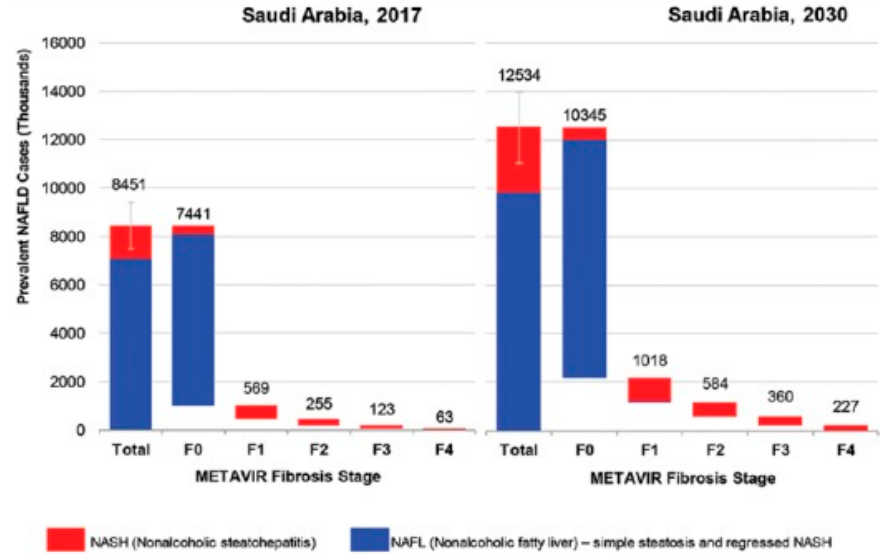
Figure 1. Distribution of NAFLD population by fibrosis stage—2017 and 2030, adapted from [4]. The progression of NAFLD involves four stages. Steatosis (simple fatty liver) is a harmless build-up of fat in the liver cells. A more severe form of NAFLD called NASH occurs when the liver becomes inflamed. A patient is diagnosed with fibrosis when persistent inflammation creates scar tissue around the liver and adjacent blood vessels, but the liver can still function normally. Cirrhosis, the most severe stage, develops after years of inflammation and causes the liver to shrink, scar, and lump; this damage is irreversible and can lead to liver failure (Figure 2). Typically, doctors divide the severity of a patient’s disease into four groups, normal, mild, intermediate, or severe, based on histological characteristics [6].